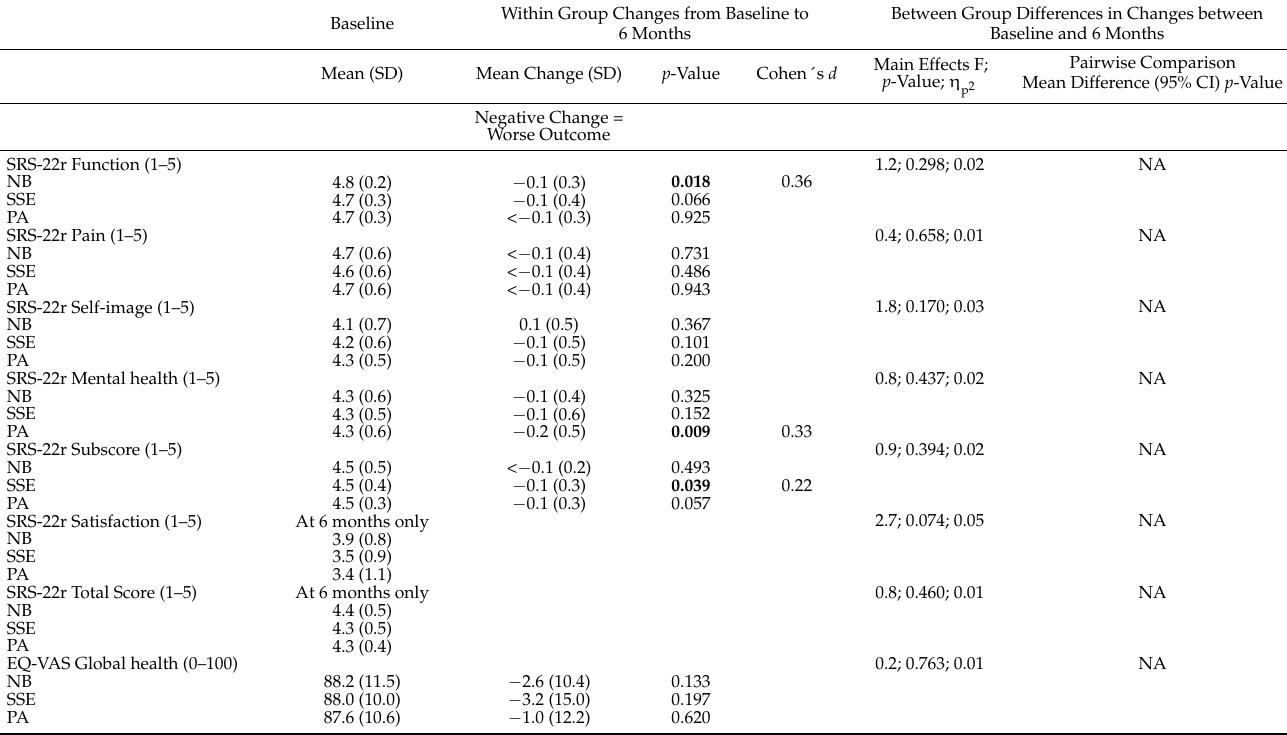
Table 5. Health-related quality of life according to the SRS-22r and EQ-VAS global health scores at baseline, within group changes from baseline to 6 months, and between group differences in changes from baseline to 6 months.